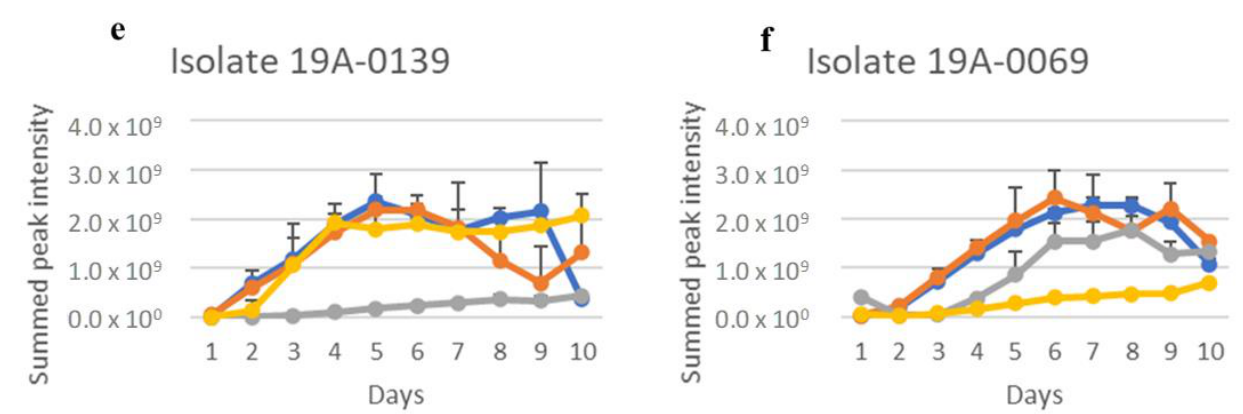
Figure 9. Ethanol production of R. stolonifer isolates in the presence of glucose, fructose, sucrose, or xylose, along with NH 4 (SO 4 ) 2 as a nitrogen source. Data presented are the relative concentration of ethanol (as determined from NMR) with standard deviation (error bars), n = 3. ( a ) Isolate 19A – 0010, ( b ) isolate 19A – 0030, ( c ) isolate 19A – 0036, ( d ) isolate 19A – 0008, ( e ) isolate 19A – 0139, ( f ) isolate 19A – 0069.